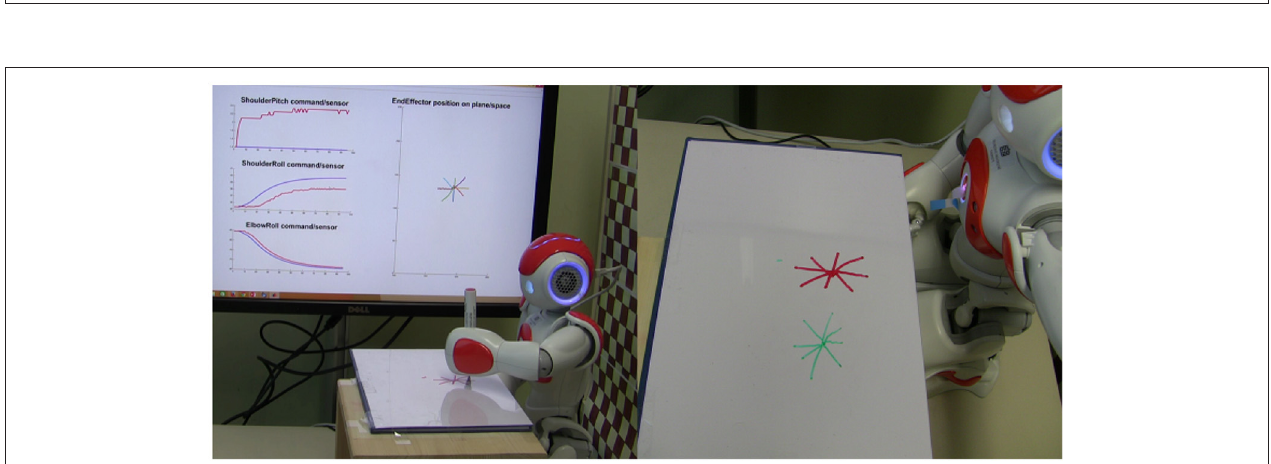
FIGURE 3 | NAO humanoid robot drawing lines for the obtained motor coordination (motor coordination parameters from Figures 2F,H ). The robot draws eight desired lines at each of the two initial positions.